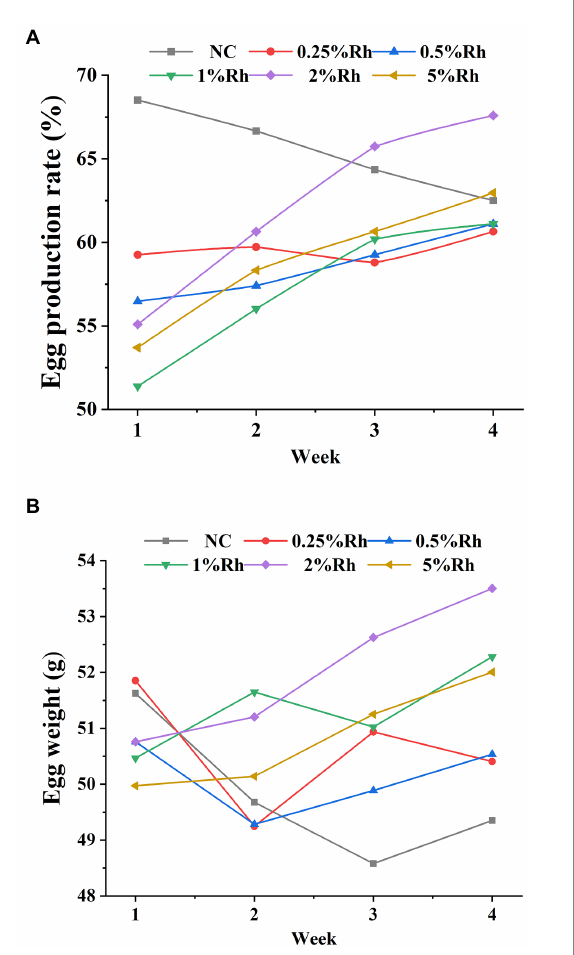
FIGURE 3 Effect of Rhodotorula glutinis fermented in TWW on the productive performance of laying hens. (A) egg production rate; (B) egg weight.